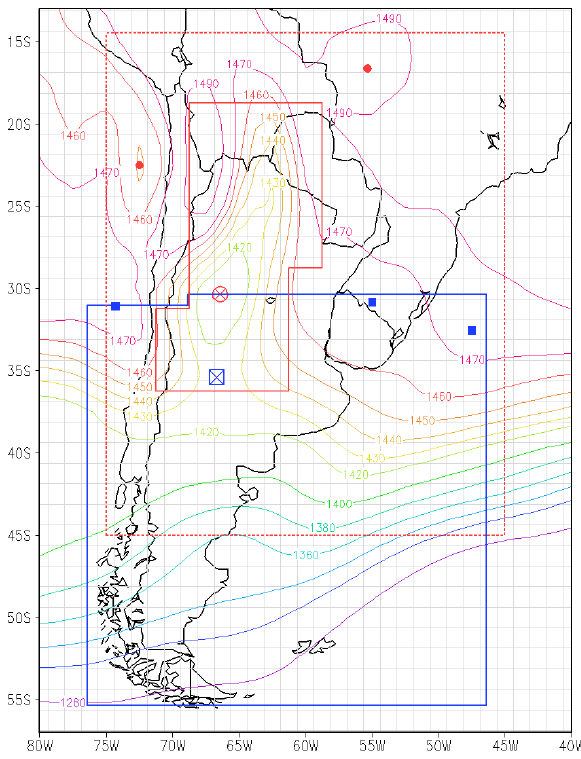
Fig. 1. Contours show φ 850 (m) at 12Z 24 December 1991. Poly- gons delimit search regions for: minimums of φ 850 (dotted red); NAL position (red); AC position (blue). Markers indicate: lows (red), NAL (big red), cols (blue), AC (blue